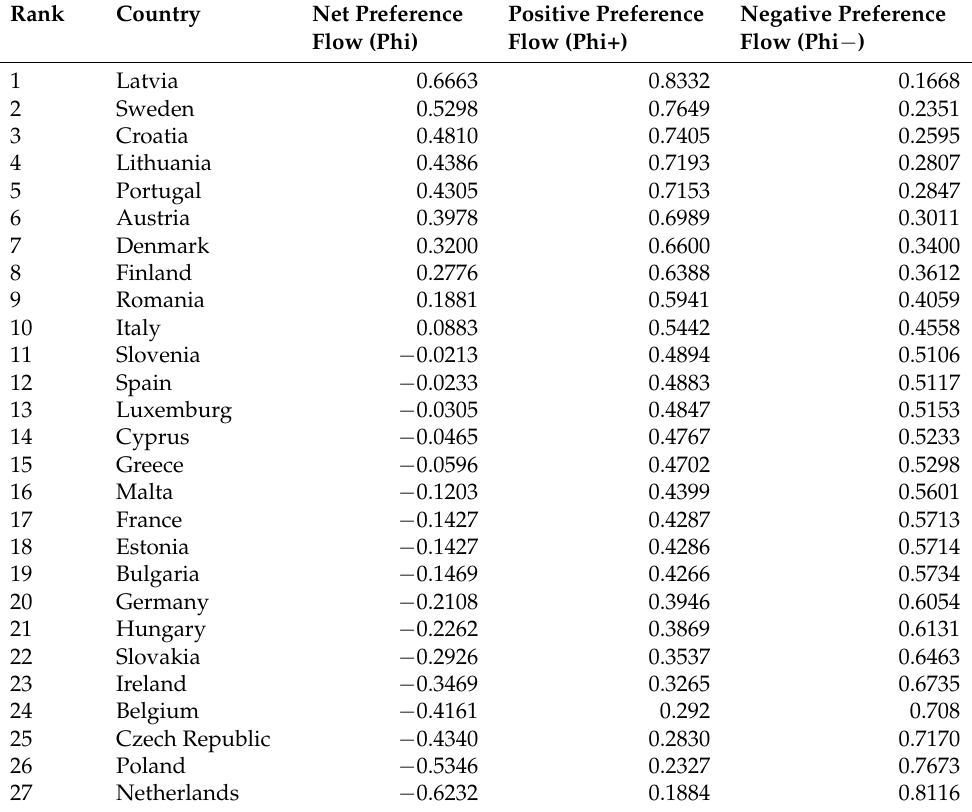
Table 6. Ranking results for 2018.